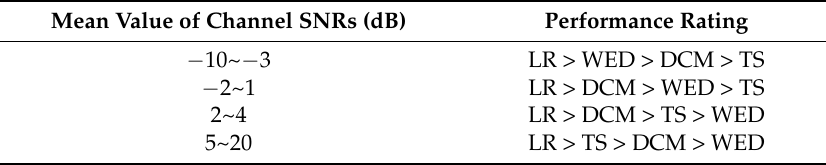
Figure 3. The probability of detection as a function of the mean value of channel SNRs for various fusion rules. Table 1. Performance rating under different SNR range.